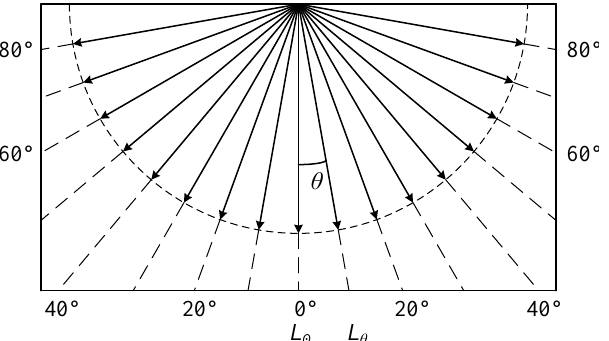
Figure 2. Schematic diagram of the normalized luminance of the standard Lambertian light source. Due to the fact that the luminance of the standard Lambertian light source is indepen- dent of direction, the standard Lambertian surface is regarded as an ideal diffuse reflection surface [14,15].